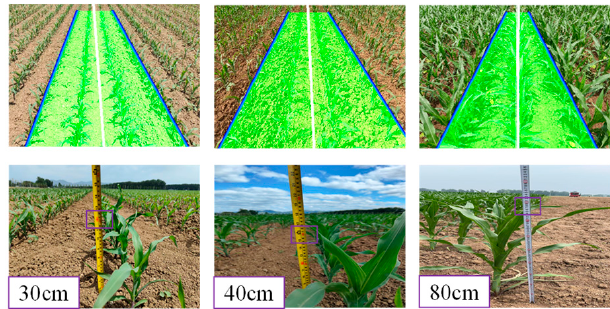
Figure 16. Test Figure 16. Test instrument. Table 1. Robustness test.